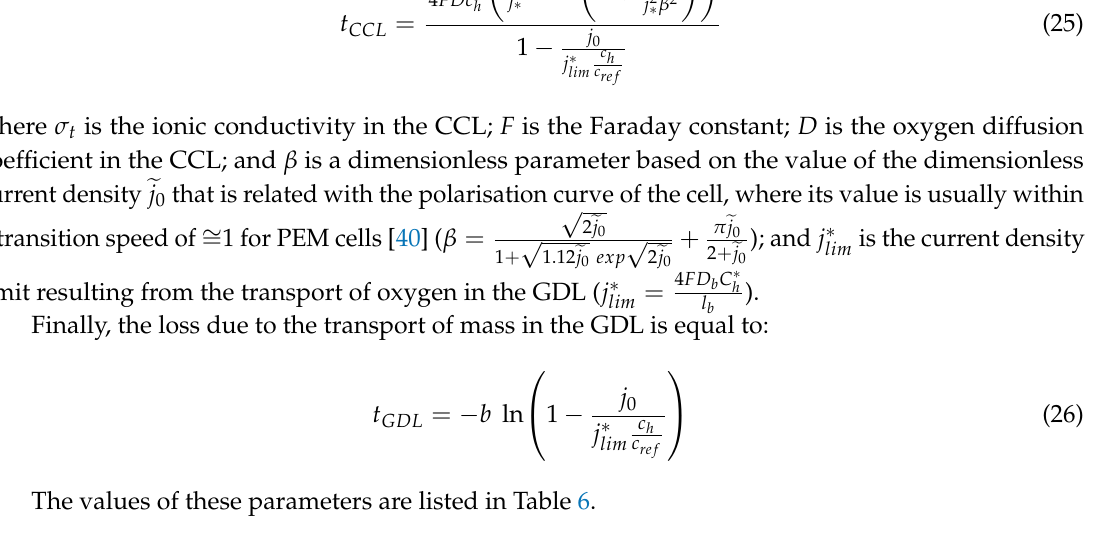
Table 6. Specifications for the polarization curve in the automotive software simulator